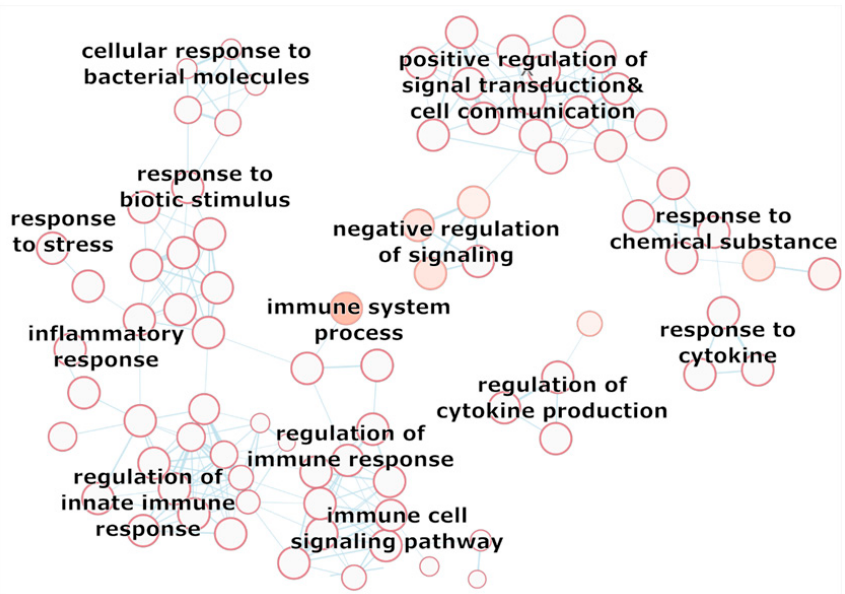
Figure 5. Selection of the Enrichment Map based on the enrichment of GO biological processes of the brain-interaction network of IL-6, TNF, NFKB1 . The interacting gen set was queried in g:Profiler, resulting in a enrichment of biological processes. The Cytoscape Enrichment Map App was used to generate the corresponding visualization of GO terms (nodes) and their gene set overlap presented as edges. Moreover, each protein is colored according to their top-level biological process. The degree of the target proteins is emphasized by node size.